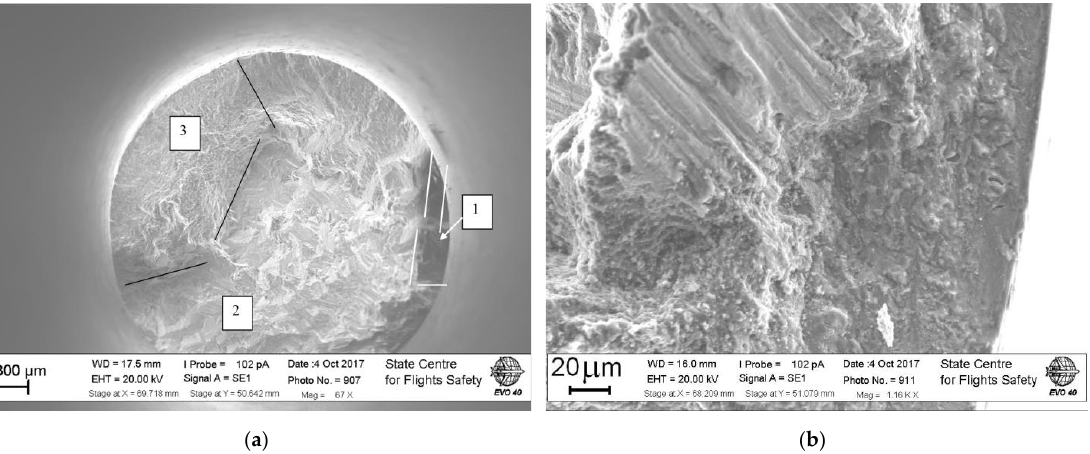
Figure 10. Typical fracture surface of hot-rolled aluminum alloy with clear three stages of crack growth ( a ) and details of translon from zone I to zone II ( b ). The analysis on quasi-brittle fracture surface in the zone II show that these elongated platelets are grouped in packages that are randomly orientated one by another (Figure 11). The linear size of these packages is about hounded micrometers.